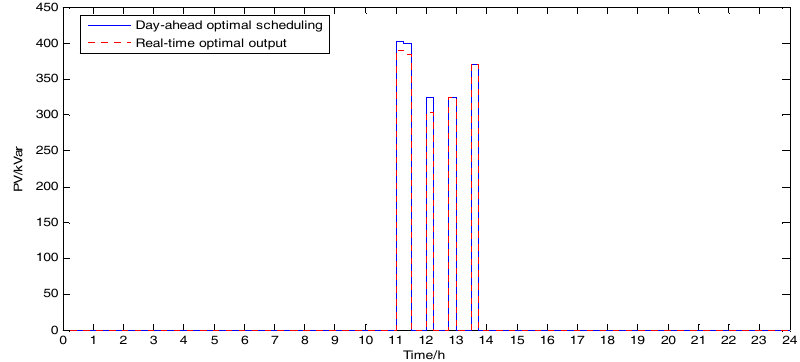
Figure 11. Optimal reactive power regulation scheduling of the PV.